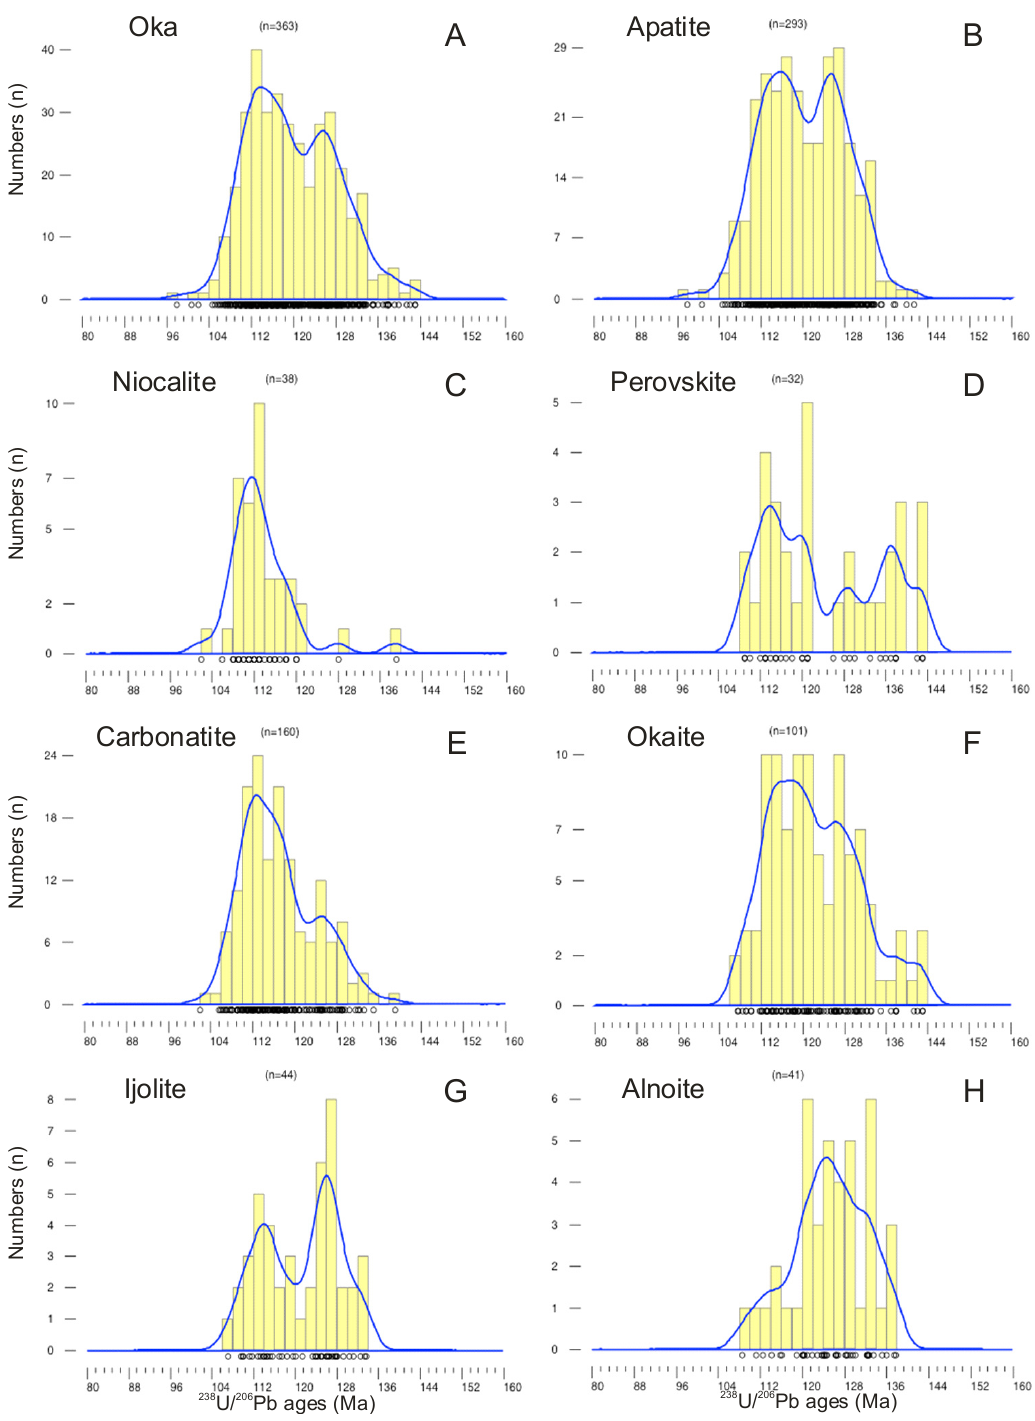
Figure 11. Kernel Density Estimation (KDE) plots for the weighted mean 206 Pb/ 238 U ages for the different rock/mineral groups. ( A ) The entire geochronological data for Oka ( n = 363); ( B ) apatite ( n = 293); ( C ) niocalite ( n = 38); ( D ) perovskite ( n = 32); ( E ) carbonatite ( n =